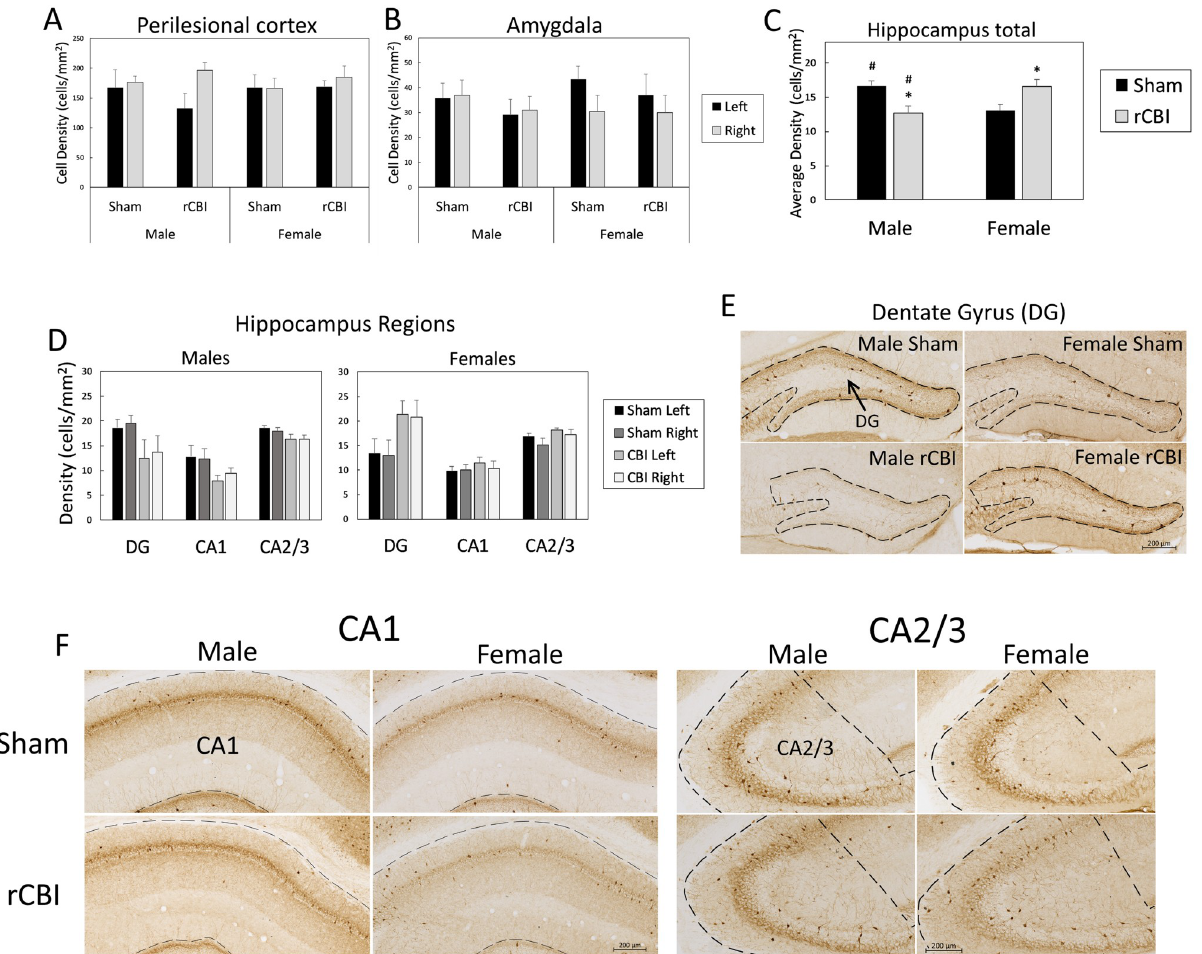
Fig 5. Parvalbumin in the brain following rCBI. All sections shown represent the approximate median value from each group. There were no effects of injury or sex on parvalbumin cell density in the cortex ( A ) or amygdala ( B ). In the hippocampus ( C-F ), rCBI decreased the overall parvalbumin cell density in males ( � , Male Sham > Male rCBI, p < 0.05), but cell density was increased in females that sustained injuries ( C ; � , Female rCBI > Female Sham, p < 0.05). Female injured mice also had a greater parvalbumin cell density than male injured mice (#, Female rCBI > Male rCBI, p < 0.05), and there were also sex differences between sham-treated animals, with male mice having a greater density of parvalbumin-reactive cells than females (#, Male Sham > Female Sham, p < 0.05). Although there was no statistically significant interaction effect with region, the sex differences were most apparent in the DG. rCBI, repetitive concussive brain injury; DG, dentate